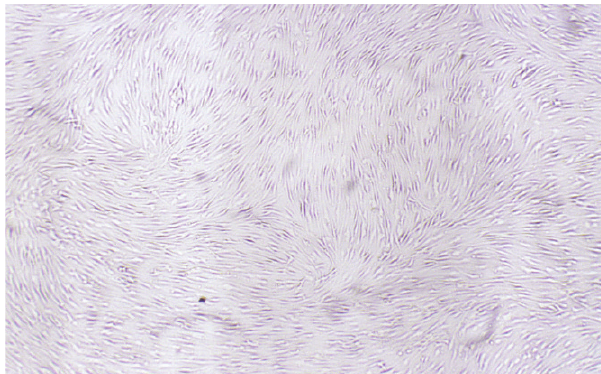
Figure 1 - The morphology of PPMCs. The cells exhibited a fibroblastoid morphology in a monolayer and then attained a stable, fibroblast-like morphology with no signs